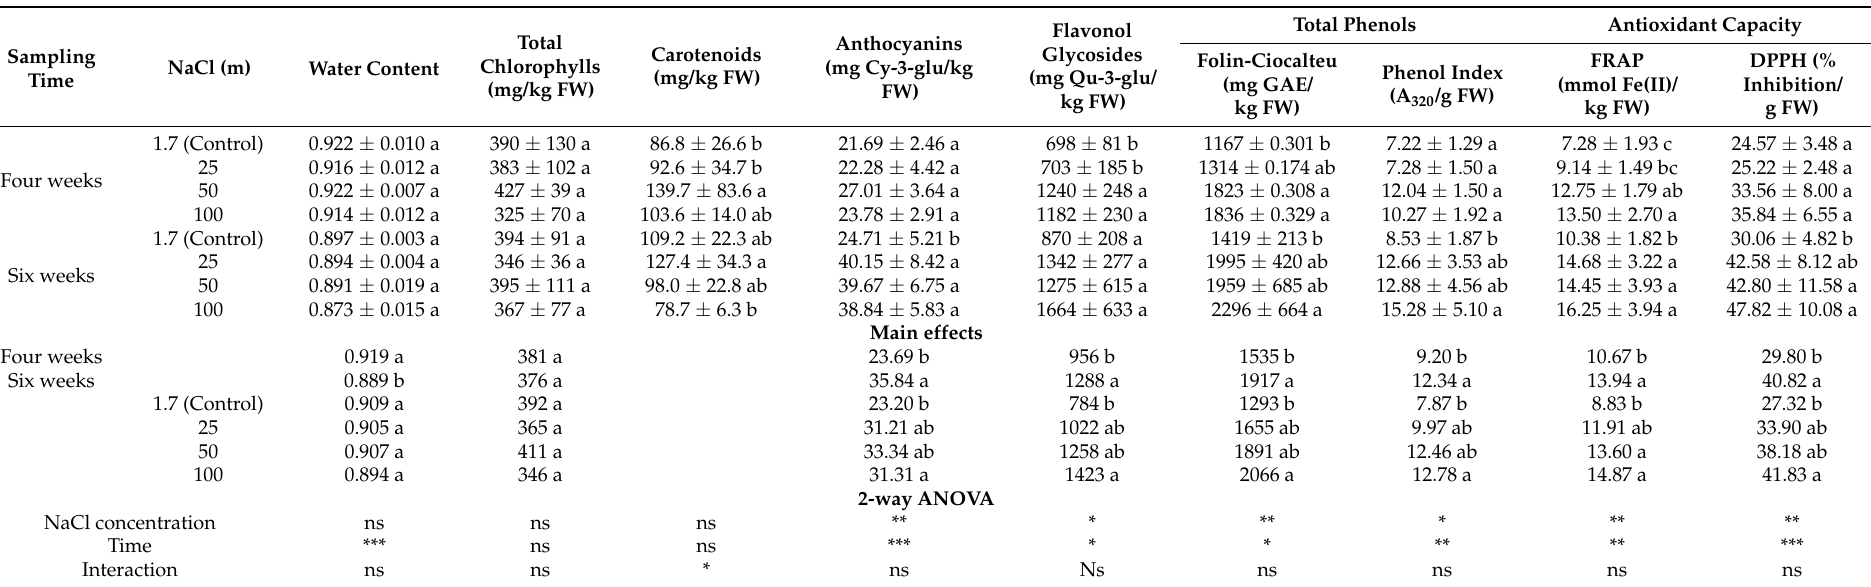
Mean values ± standard deviation of four replicates. For each parameter and sampling time, different letters among the treatments indicate significant difference at p < 0.05. Cy-3-glu: cyanidine-3-gucoside; Qu-3-glu: quercetin-3-glucoside; GAE: gallic acid equivalents; FW: fresh weight. Asterisks denote statistical significance according to 2-way ANOVA: ***, significant at p < 0.001; **, significant at p < 0.01 *, significant at p < 0.05; ns, not